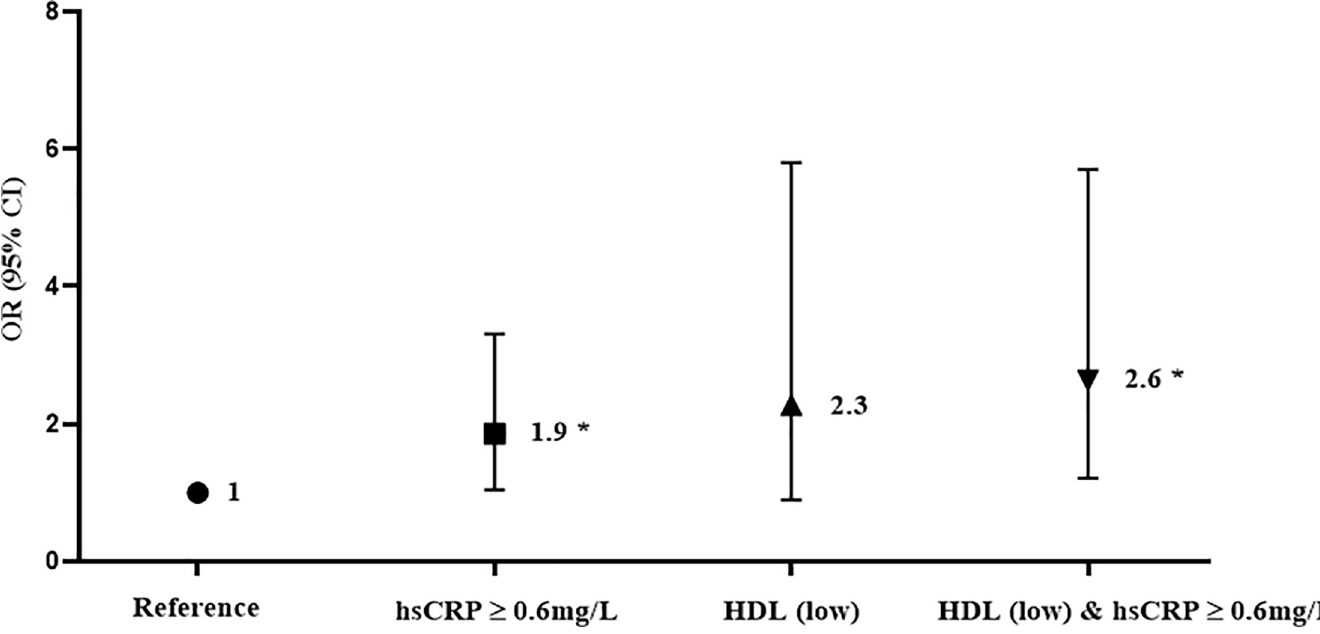
Fig 1. Association between the concurrent presence of inflammatory and metabolic factors and the development of rotator cuff tear in hand osteoarthritis. Adjusted for sex, age, level of education, body mass index and total sum of Kellgren–Lawrence grades. Abbreviation: RCT, rotator cuff tear; hsCRP, high-sensitive C- reactive protein; HDL, high-density lipoprotein cholesterol; M, male; F, female; OR, odds ratio; CI, confidence interval � p <